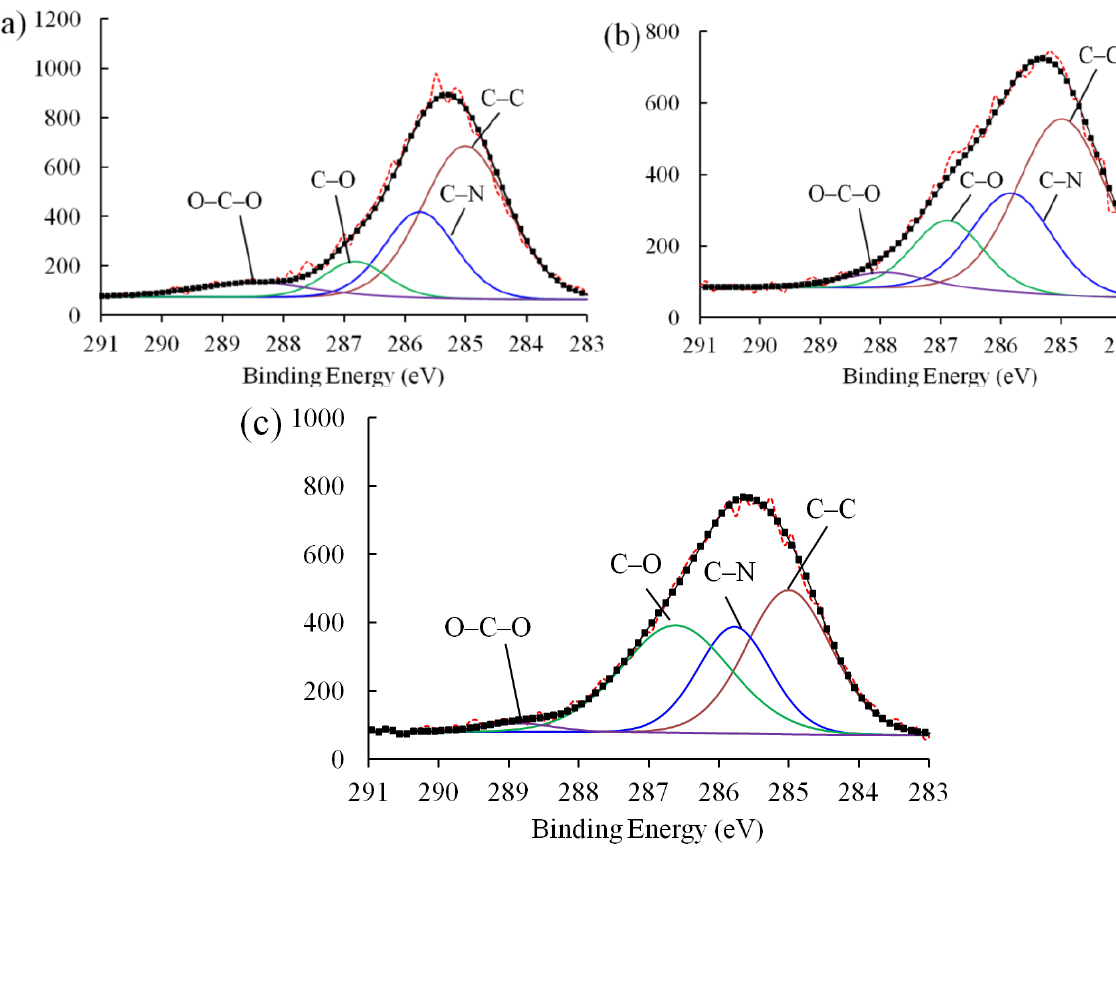
Figure 8. C 1s peaks of the deconvoluted XPS spectra of ( a ) the pure epoxy resin; ( b ) the nanocomposite with as-received nanoparticles; and ( c ) the nanocomposite with plasma polymer coated